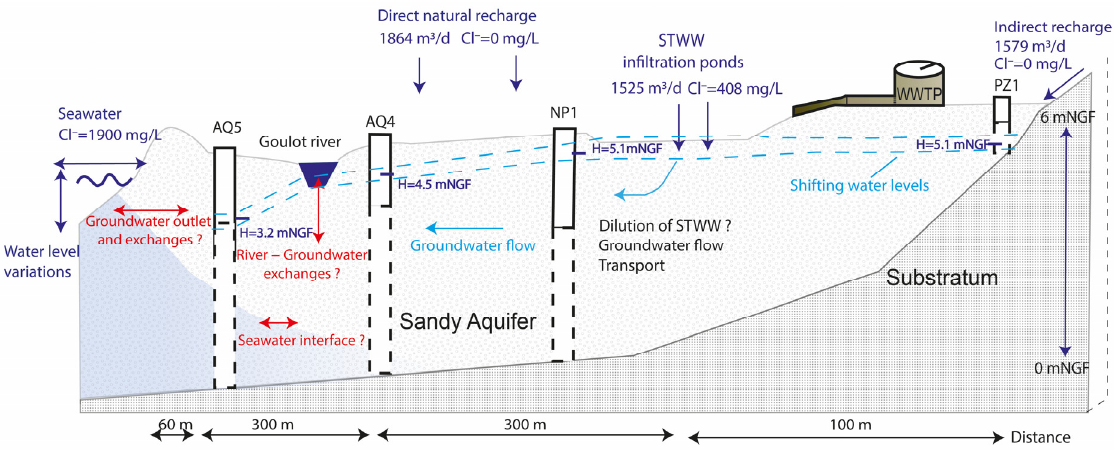
Figure 4. Conceptual model of the Agon-Coutainville SAT. Water balance and Cl − concentrations in the hydrosystem.